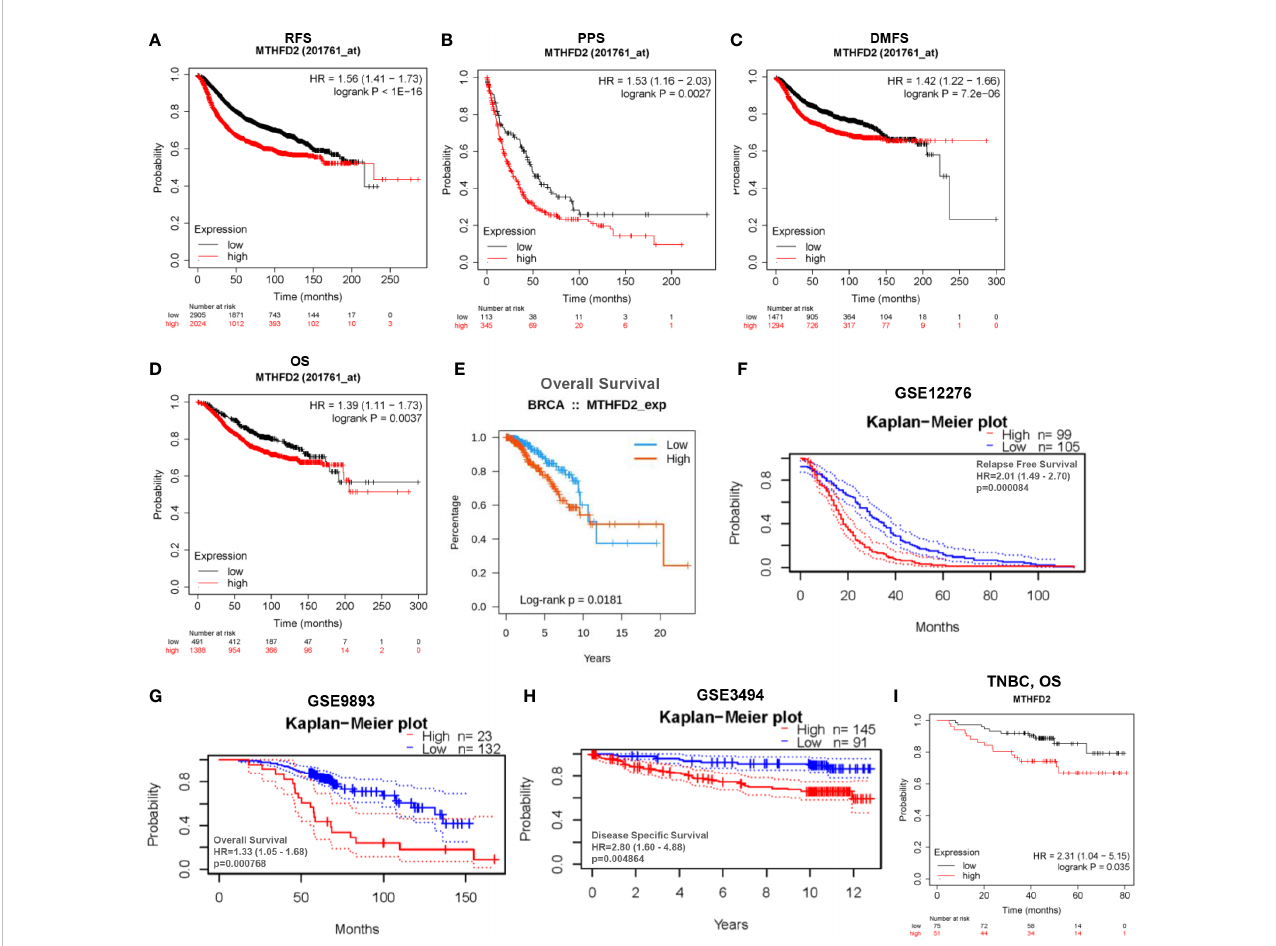
FIGURE 5 Analysis of patient prognosis in breast cancer. (A – H) Relationship between MTHFD2 expression and prognosis in breast cancer patients. (A – D) Kaplan-Meier curves were constructed based on the Kaplan-Meier Plotter database. (A) RFS, recurrence-free survival; (B) PPS, post-progression survival; (C) DMFS, distant metastasis-free survival; (D) OS, overall survival. (E) Survival curves for patients with breast cancer based on data obtained from the TISIDB database. (F – H) Kaplan-Meier curves were drawn based on the GEO database with data obtained from the PrognoScan database. (F) GSE12276, relapse free survival; (G) GSE9893, overall survival; (H) GSE3494, disease speci fi c survival. (I) Kaplan-Meier curve drawn based on the Kaplan – Meier Plotter database for predicting overall survival in TNBC